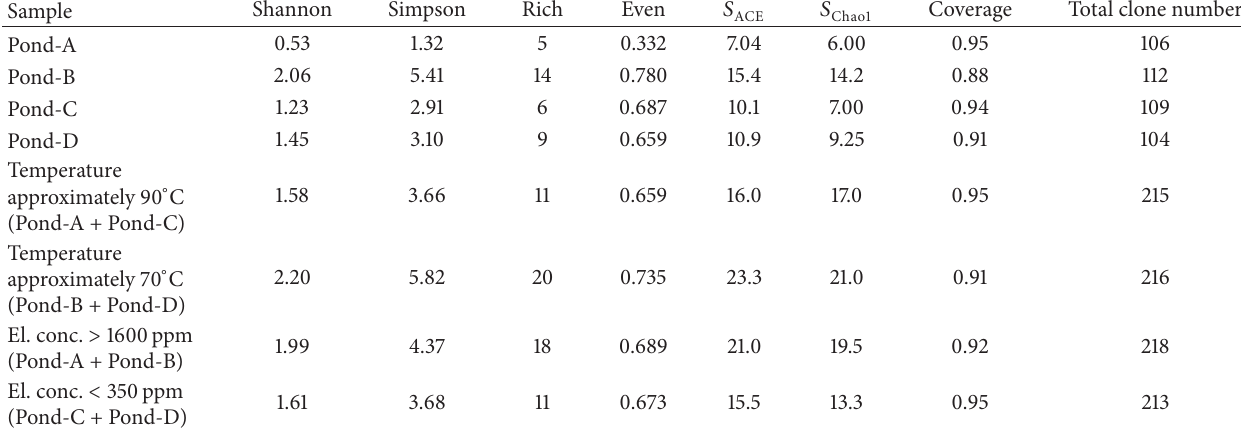
Table 3: Diversity index scores for clone